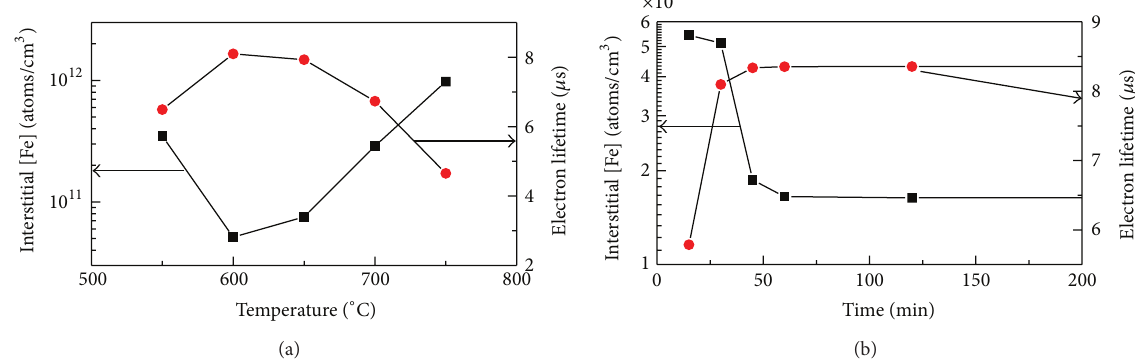
Figure 5: Calculated interstitial Fe concentration and the electron lifetime with (a) the temperature and (b) the time during the second step of the gettering process. The electron lifetime showed the highest value at the temperature of 600 ∘ C, where the interstitial Fe concentration indicated the lowest value. On the other hand, with the increase of the time they were saturated above 50